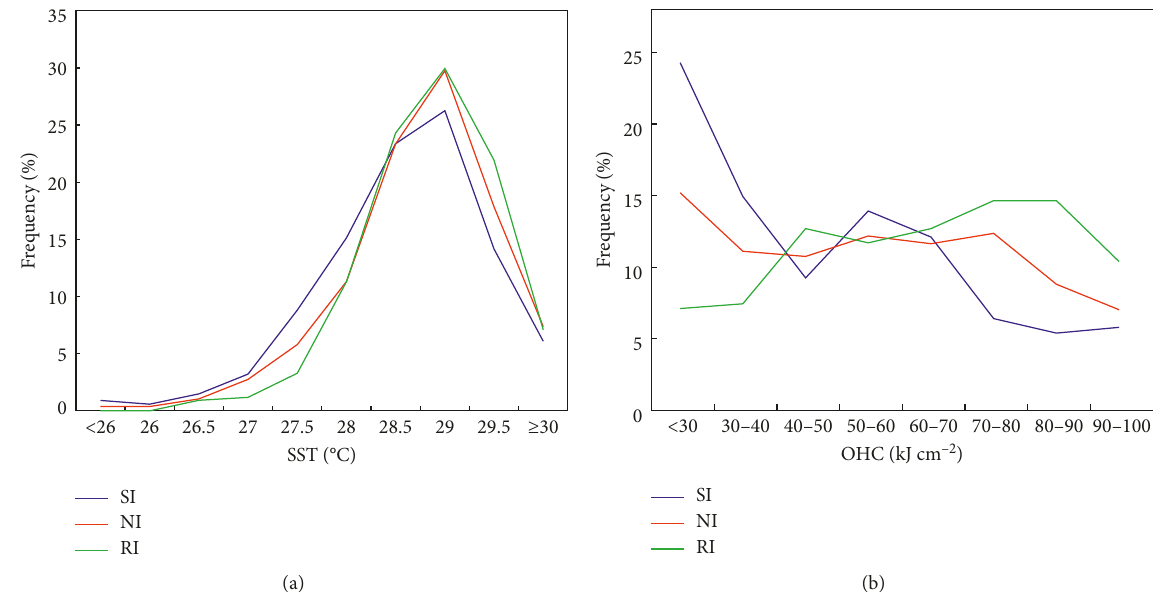
Figure 14: As in Figure 8, but for ocean heat condition. (a) SST ( ° C). (b) OHC (kJ cm − 2 ).